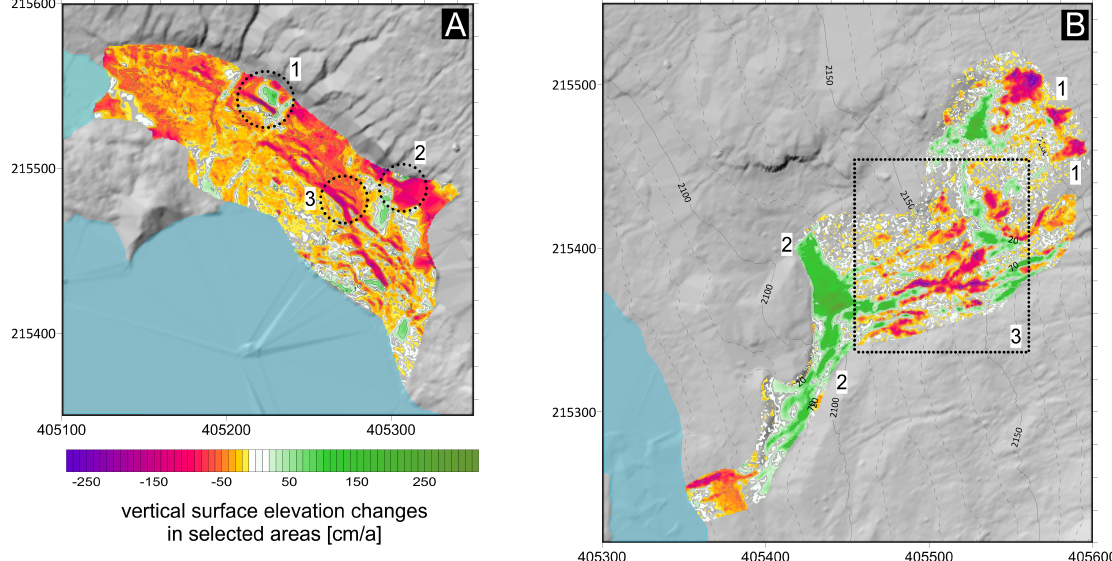
Figure 6. Examples of valley bottom and slope processes at Pasterze glacier terminus area. Calculated vertical surface elevation differences are based on TLS measurements from 2018-08-04 and 2019-08-03. ( A ) Slide at footslope area towards the Lake Pasterzensee, where 1–3 indicate special patterns of vertical surface elevation changes. ( B ) Erosional processes with detectable detachment areas (1), accumulation